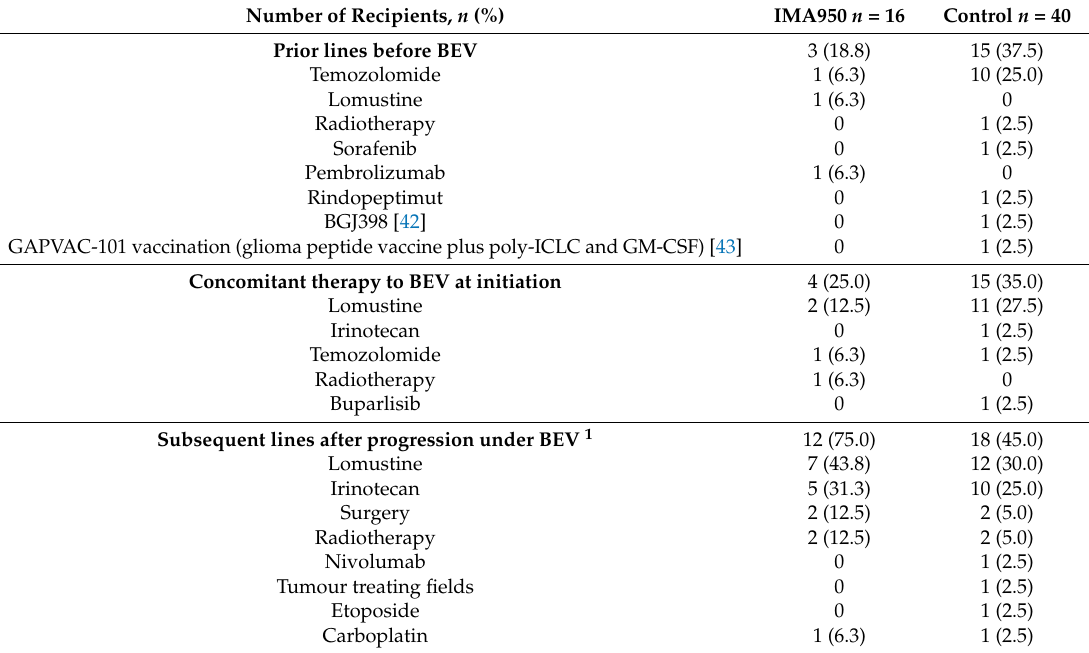
Table A1. Detailed list of treatment modalities administered at progression after standard of care. Number of Recipients, n